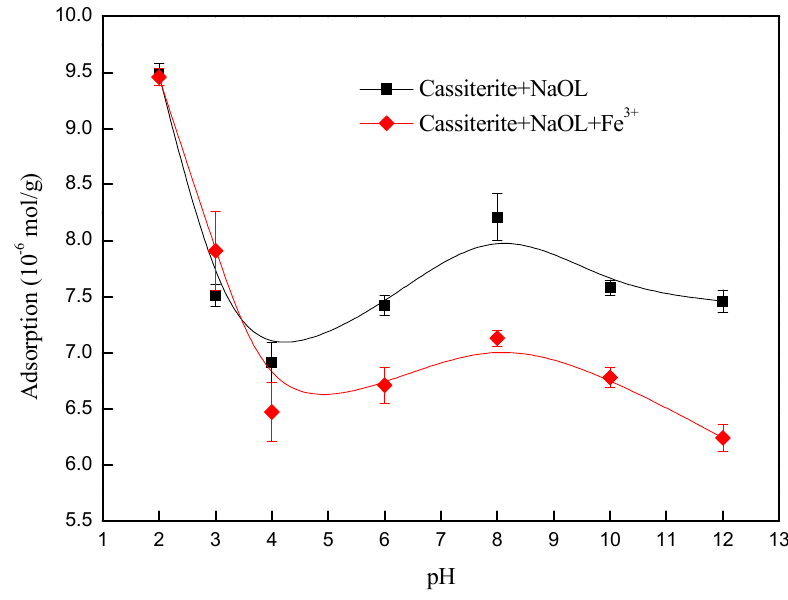
Figure 10. Adsorption of NaOL on cassiterite as a function of pH with and without Fe 3+ (Fe 3+ : 8 × 10 − 5 mol/L; NaOL: 4 × 10 − 4 mol/L).